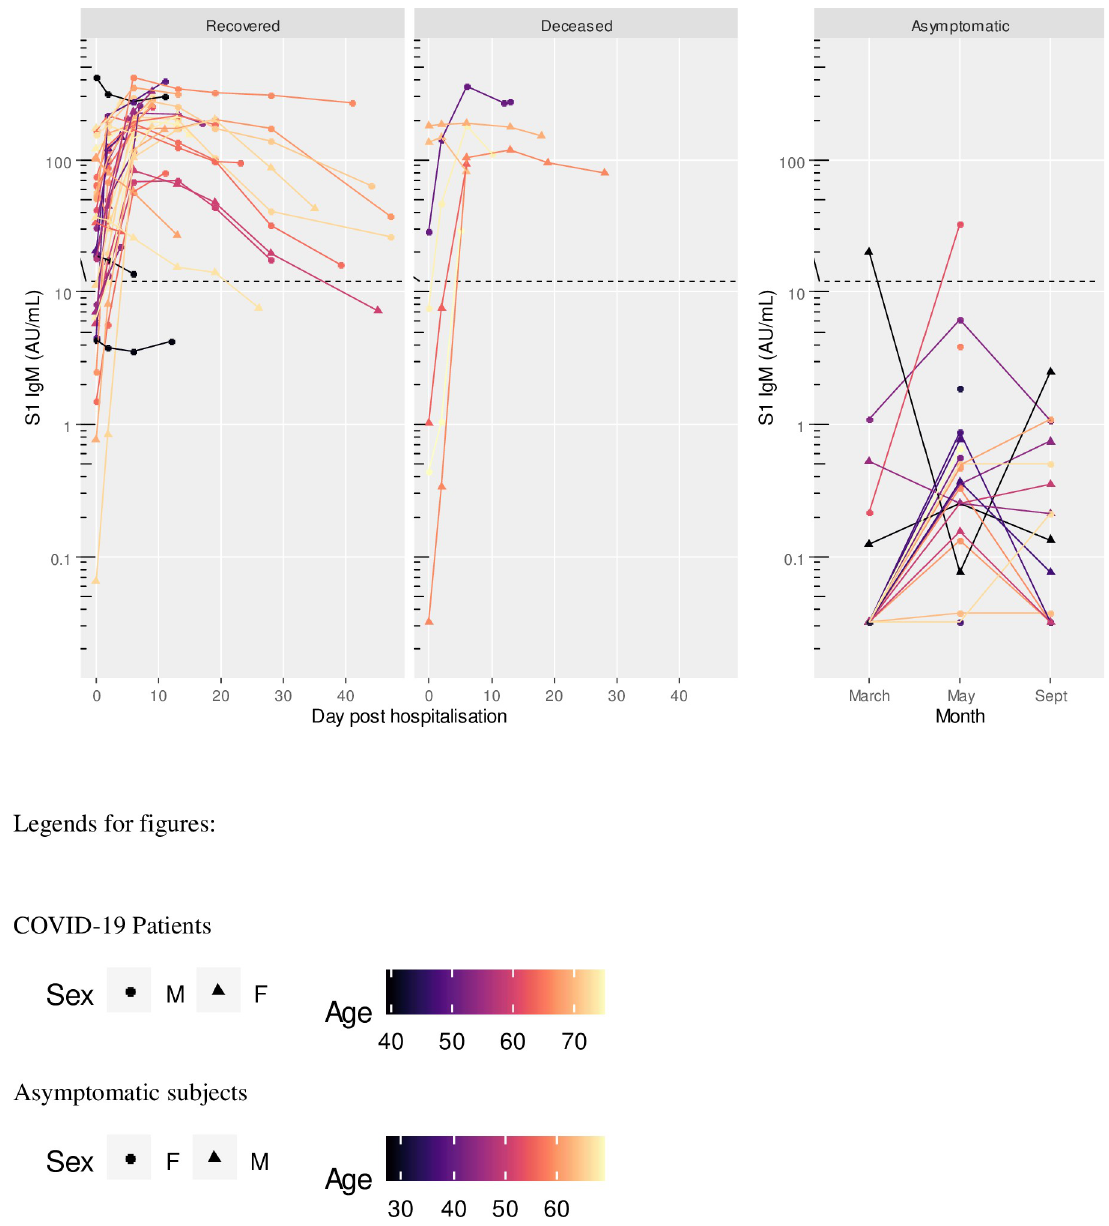
Fig 1. S1 IgM titres in COVID-19 patients (recovered and deceased) and asymptomatic subjects. Black dashed line indicates positivity threshold at 12